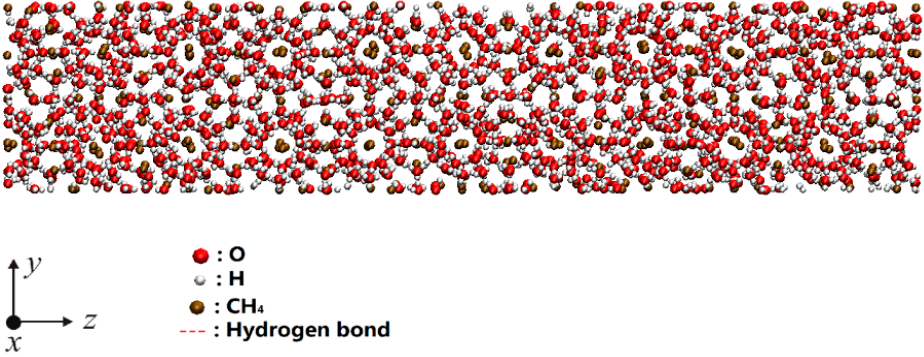
Figure 4. Simulation model for 2 × 2 × 10 unit cells of sI methane hydrate.